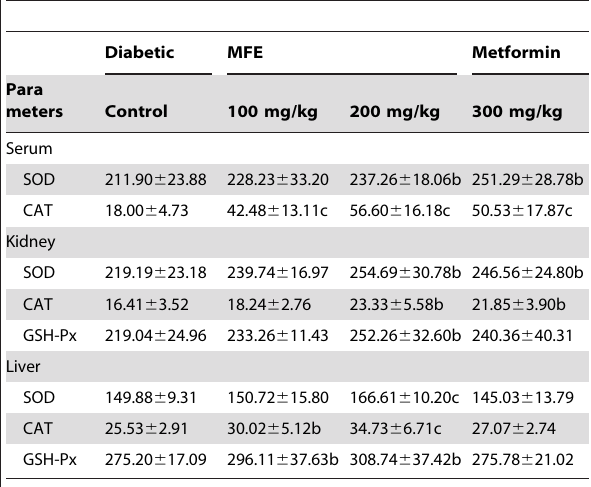
Table 4. Effect of the MFE on Antioxidant Enzyme Activities of STZ-induced Diabetic Mice. a